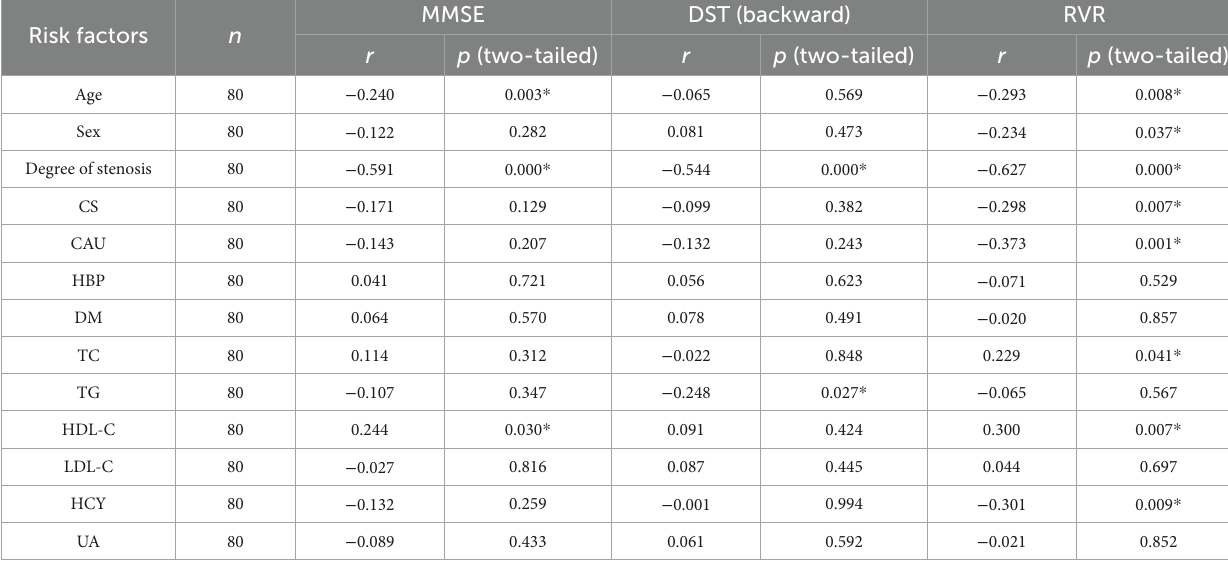
TABLE 3 Pearson correlation analysis between vascular risk factors and impaired cognitive function in asymptomatic patients with left carotid artery